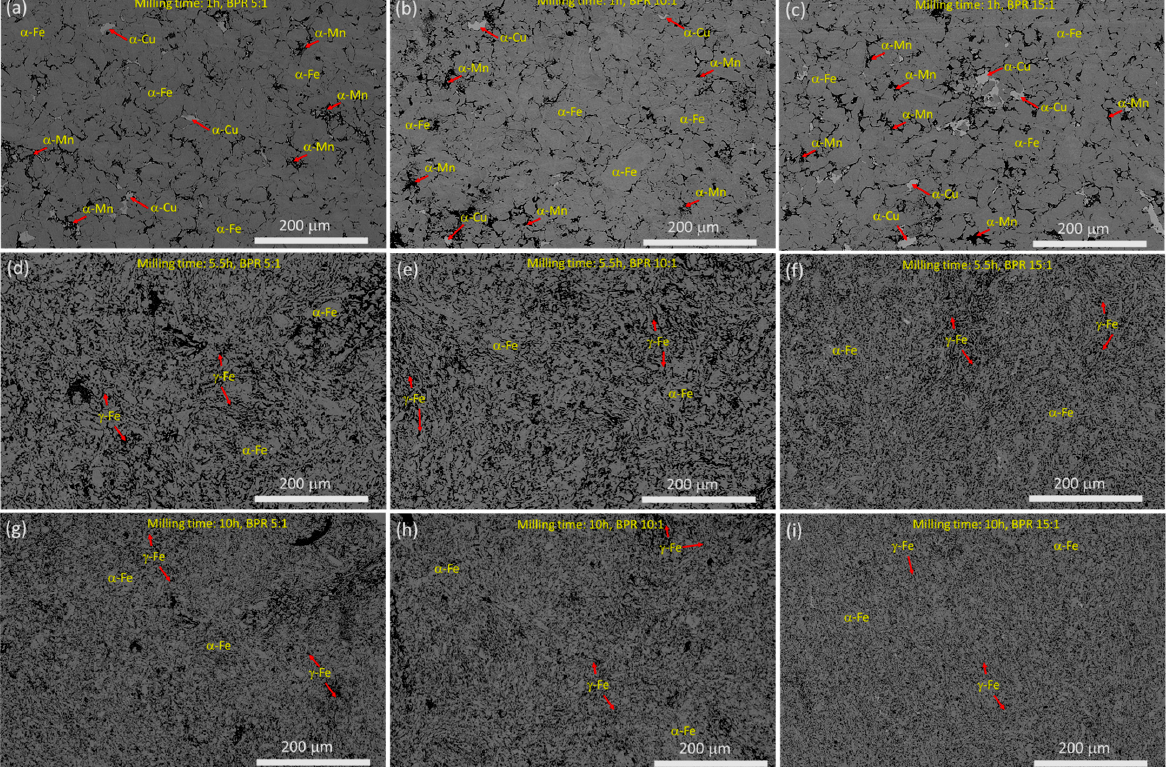
Figure 4. FE-SEM microstructures of FeMn 30 Cu 5 hot-forged biodegradable alloys processed at dif- ferent milling conditions: ( a ) 1 h with BPR 5:1; ( b ) 1 h with BPR 10:1; ( c ) 1 h with BPR 15:1; ( d ) 5.5 h with BPR 5:1; ( e ) 5.5 h with BPR 10:1; ( f ) 5.5 h with BPR 15:1; ( g ) 10 h with BPR 5:1; ( h ) 10 h with BPR